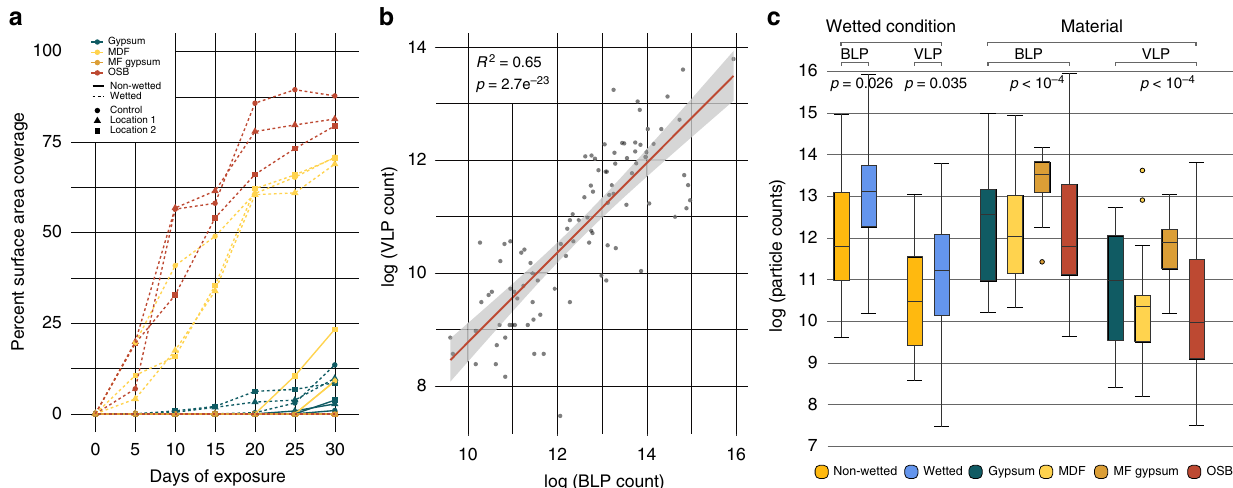
Fig. 1 Microbial growth rates vary across sample types. a Percent of surface area covered by visible microbial growth through time ( n = 168, 4 materials, 3 locations, 2 wetting conditions, 7 time points). Color indicates coupon material, point shape indicates inoculating location, and line type indicates whether the coupon was wet before incubation. b Correlation in the counts of bacteria-like (BLP) and viral-like particles (VLP) across all coupons ( n = 96 samples, 4